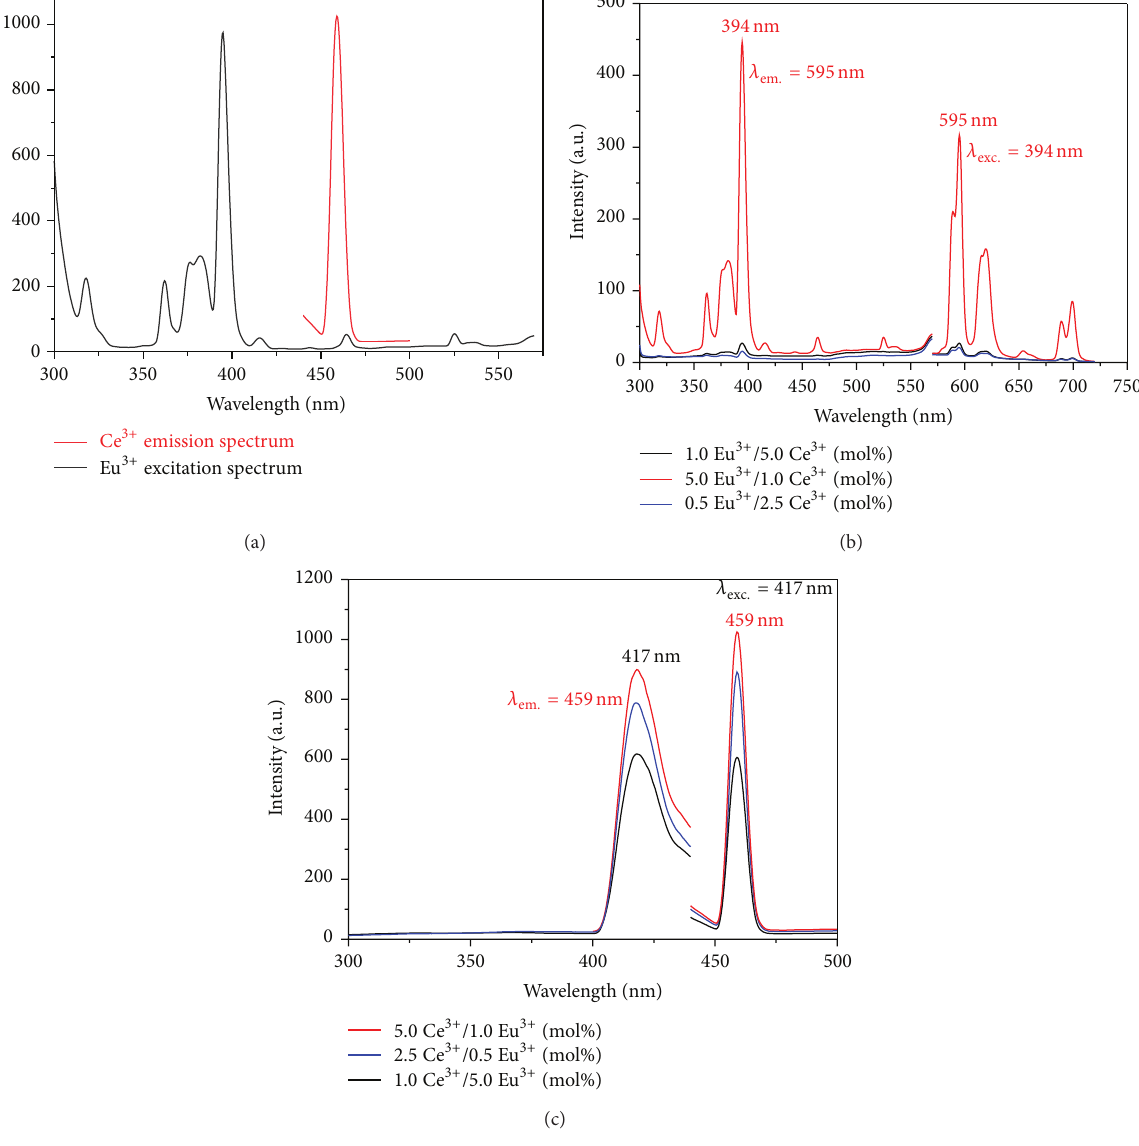
codoped samples with 394 nm, and 417nm excitation